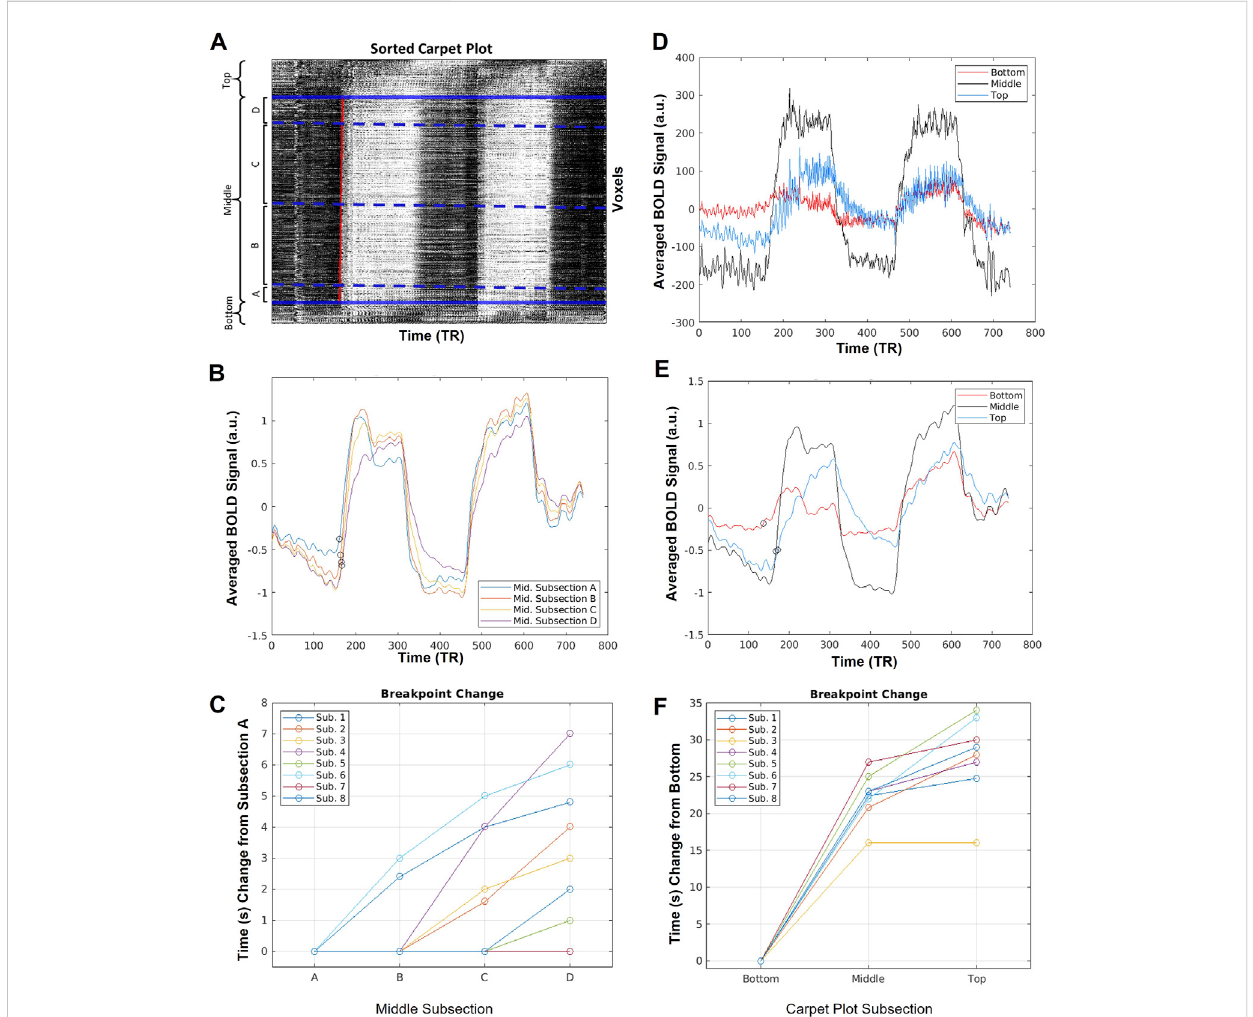
FIGURE 3 Sampleaveragedtimeseriescomputedduringcarpetplotanalysis. (A) Displayofexamplesortedcarpetplot,wheretheredlinerepresentstheedge computed during edge detection applied to the cropped carpet plot. Solid blue lines indicate the boundary of regions removed before edge detection, and divide the carpet plot into the “ top ” , “ middle ” , and “ bottom ” regions, as labeled. Dotted blue lines indicate boundaries for four subsections, (A – D), of the middle region; these subsections are de fi ned by grouping voxels with assigned delay times falling within four 5-s windows (a division, into four groups, of the 20-s span of delays assigned to voxels in the middle section). (B) Display of the averaged time series of voxels in each middle subsection after normalization (detrending and dividing by standard deviation) of each individual voxel time series. Circles mark estimates of the time series breakpoints. (C) Plot of change in estimated breakpoint between middle subsection averaged time series. Plotted times indicate change relative to the estimated breakpoint of subsection A. (D) Display of the averaged time series of voxels from the top, middle, and bottom sections of the carpet plot withoutnormalizationofthetimeseries. (E) Displayoftheaveragedtimeseriesofvoxelsfromthetop,middle,andbottomsectionsofthecarpetplotafter normalization(detrendinganddividingbystandarddeviation)ofeachtimeseries.Circlesmarkestimatesofthetimeseriesbreakpoints. (F) Plotofchange in estimated breakpoint between bottom, middle, and top carpet plot averaged time series. Plotted times indicate change relative to the estimated breakpoint of the bottom